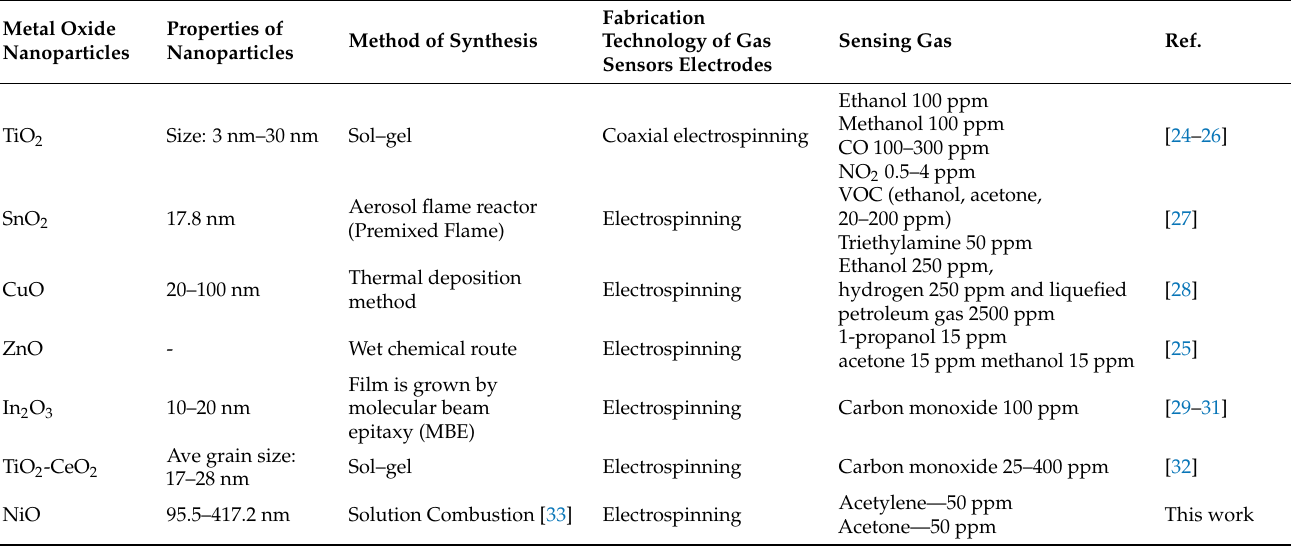
Table 1. Summary of studies of metal oxide nanoparticles for gas